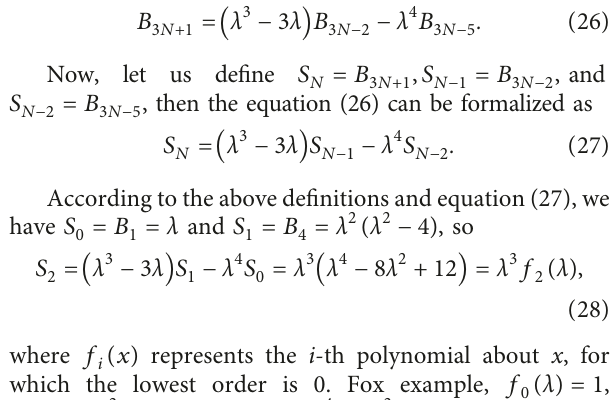
Table 1: N of extended-path networks. D